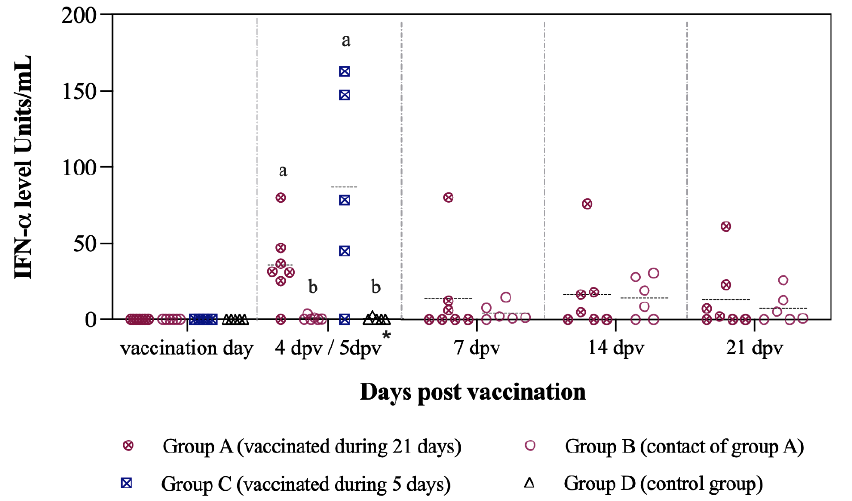
Figure 3. IFN- α levels in sera after vaccination during 21 days. The IFN- α levels were determined at different time points after vaccination with a single dose of the Thiverval-strain vaccine. Asterisk symbol (*) refers to 4 dpv for groups A and B, and 5 dpv for groups C and D. Letters above the symbols are used to represent statistically significant differences between the groups on that day: similar letters indicate no statistical difference and different letters show statistical difference ( p < 0.05).